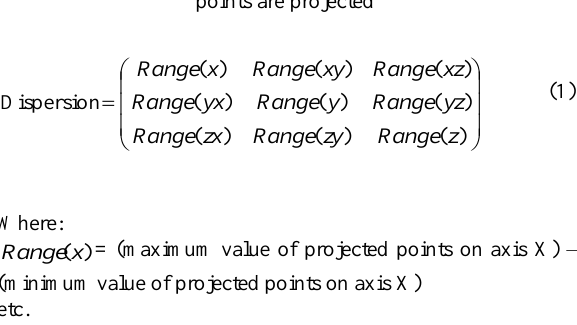
Figure 1. Three Cartesian and six non-Cartesian axes on which points are